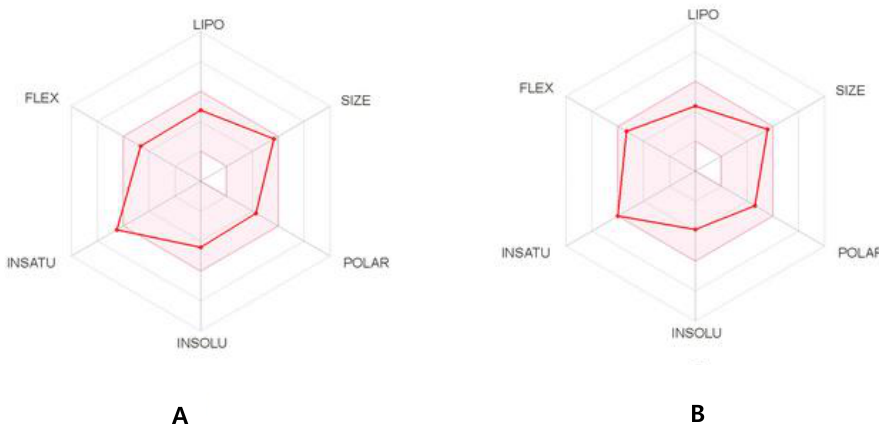
Figure 8. The bioavailability radar of T3 ( A ) and T6 ( B ).